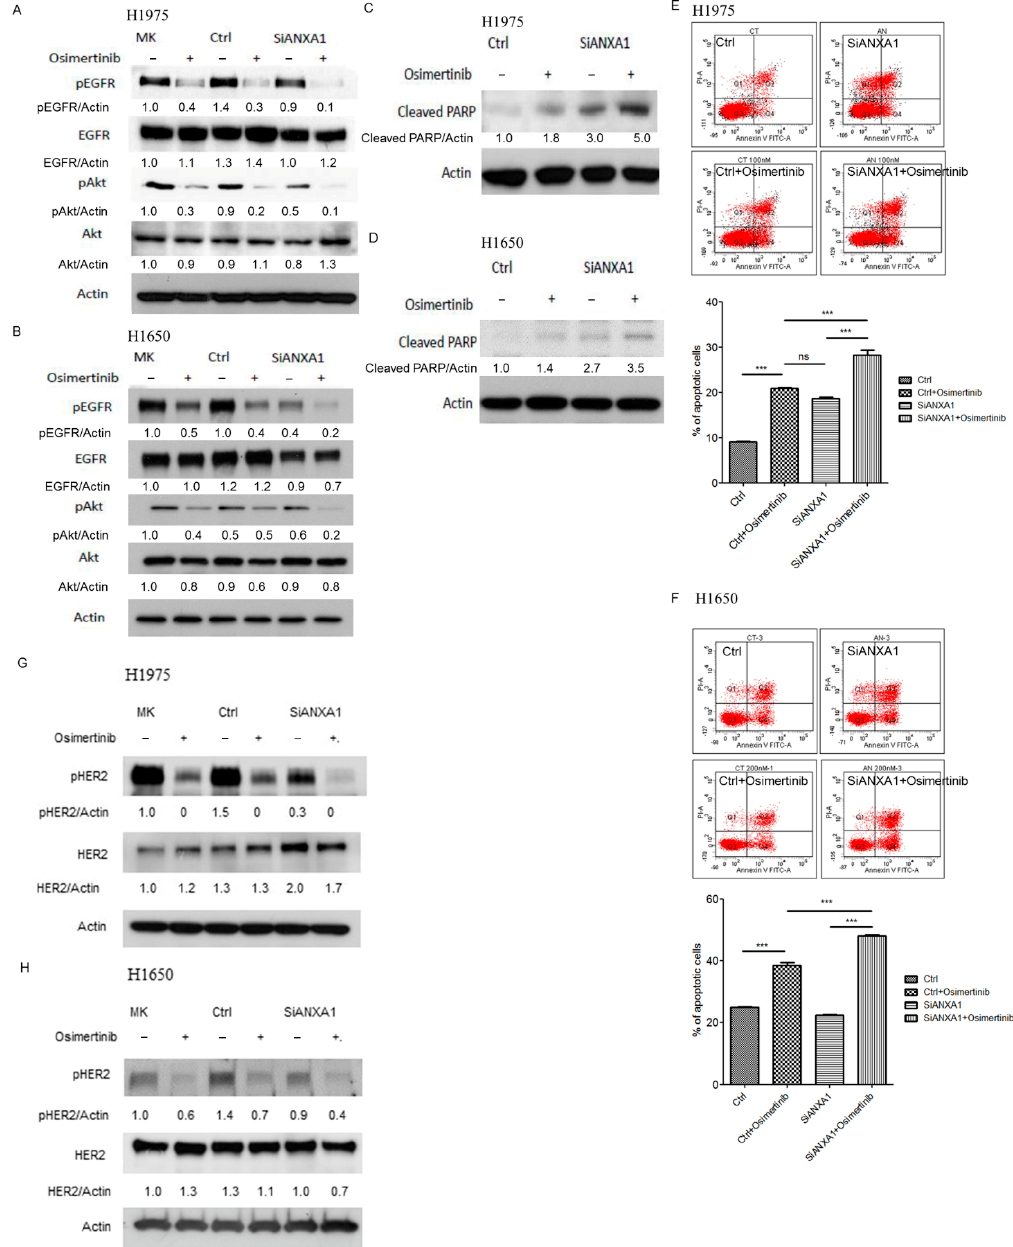
Figure 4. Western blot analysis of EGFR, pEGFR (Tyr1068), Akt (Ser473), pAkt and actin in ( A ) H1975 and ( B ) H1650 lung cancer cells transfected with 50 nM scrambled control (Ctrl) and ANXA1 (SiANXA1) siRNA for 72 h and then treated with 10 nM Osimertinib for 3 h. MK: mock, without transfection of siRNA. The relative expression of pEGFR, EGFR, pAkt and cleaved PARP were normalized to actin using MK group as the control. MK: mock; pEGFR: phosphor EGFR; pAkt: phosphoAkt. Western blot analysis of cleaved PARP in ( C ) H1975 and ( D ) H1650 lung cancer cells transfected with 50 nM scrambled control (Ctrl) and ANXA1 (SiANXA1) siRNA for 72 h and then treated with or without 100 nM Osimertinib for 24 h. Actin was used for internal control. The relative expression of ANXA1 was normalized to actin using Ctrl group as the control. Apoptosis assay by Annexin V-FITC in ( E ) H1975 and ( F ) H1650 lung cancer cells after transfection of 50